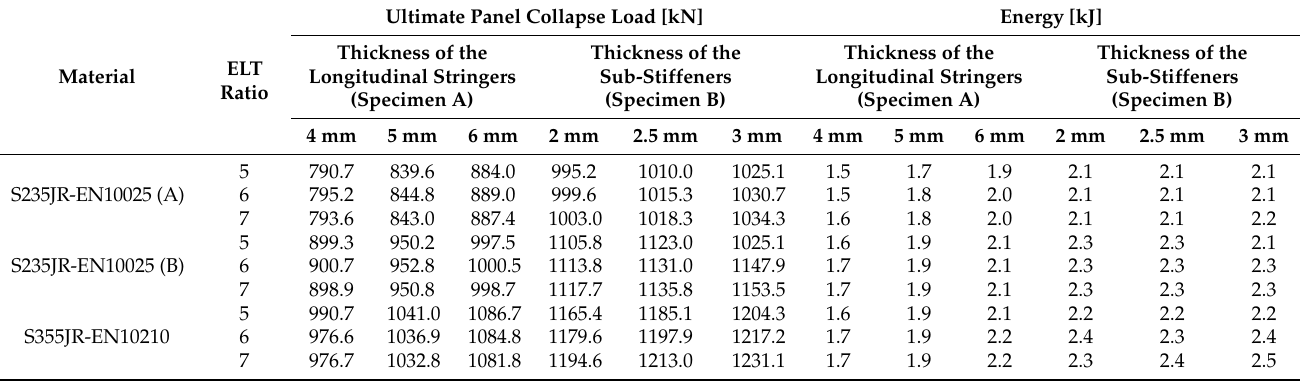
Table 11. Effect of the materials and thickness of stiffeners to ultimate panel collapse